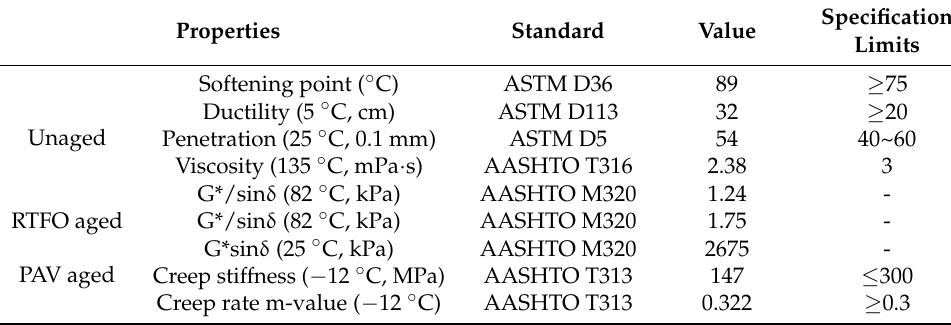
Table 1. Properties of SBS modified bitumen.